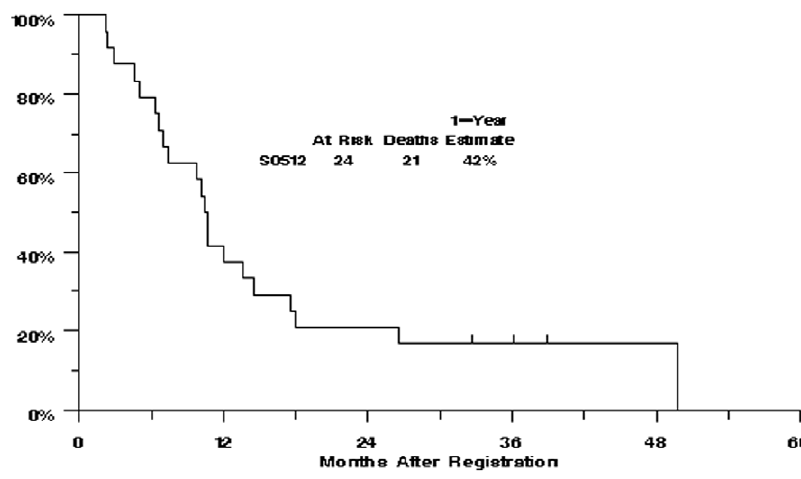
Figure 3. Kaplan-Meier curve for overall survival in evaluable patients (n=24).